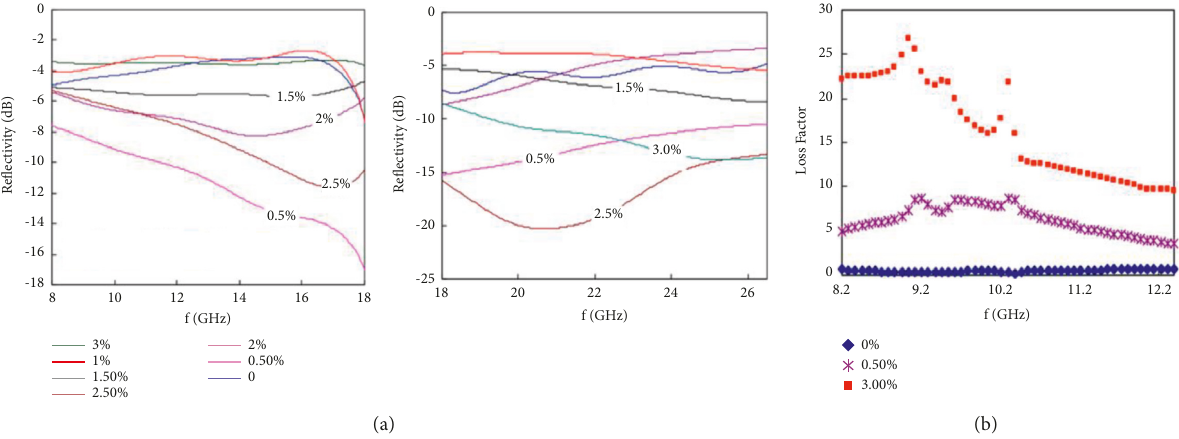
Figure 22: (a) Absorption performance and (b) loss factors of smart NCBC with different contents of NCB